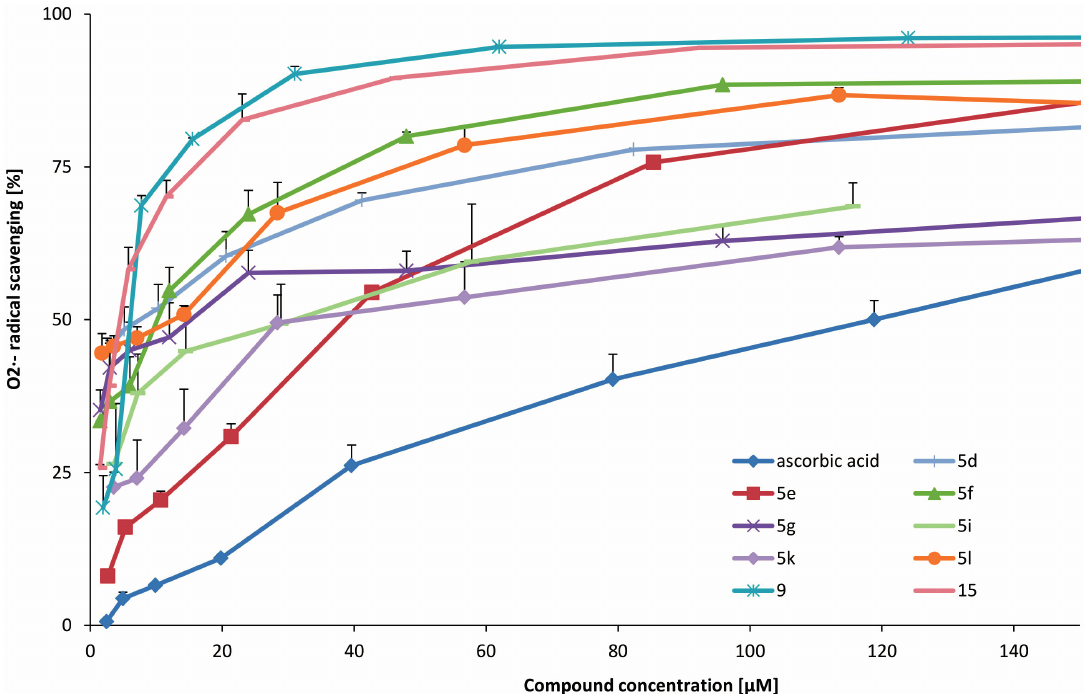
Figure 3. O 2· − scavenging of the most active